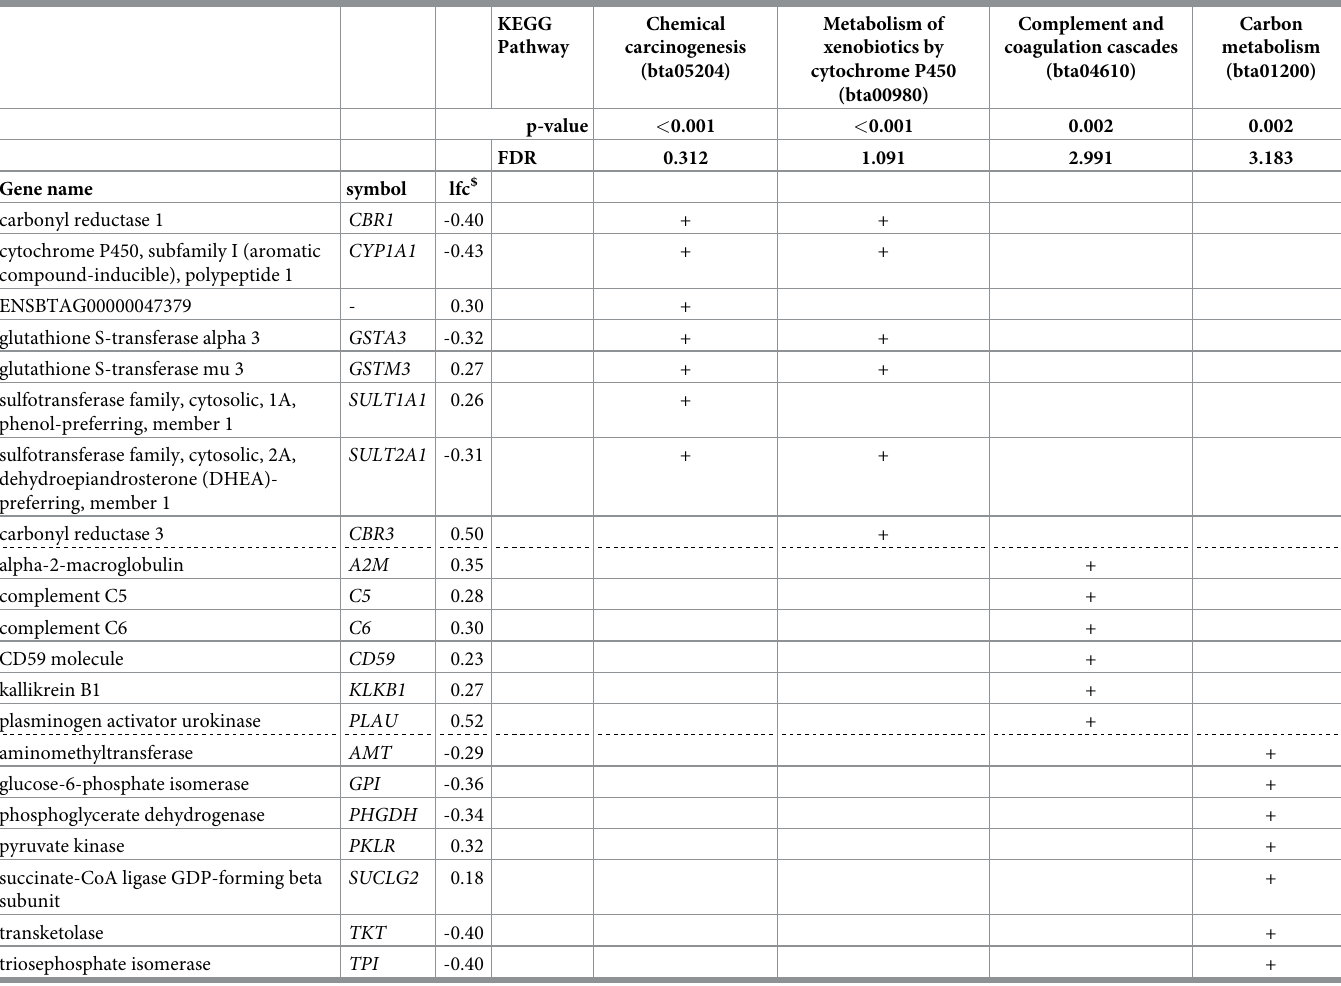
Table 2. Functional clustering of CFP-responsive genes by using